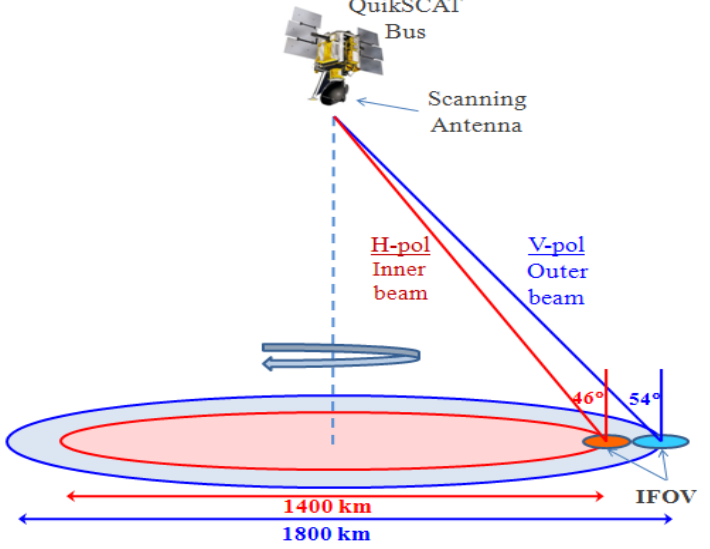
Figure 1. QuikSCAT conically scanning measurement